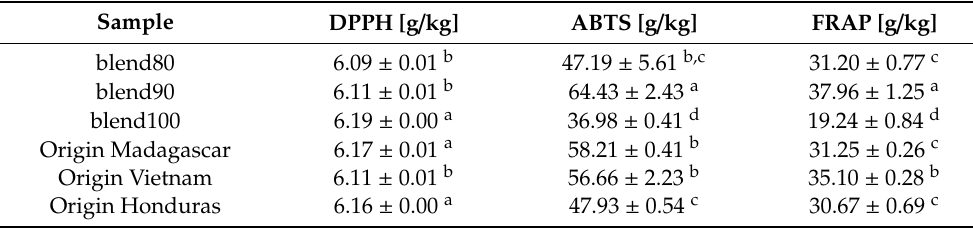
Table 2. The antioxidant activity of